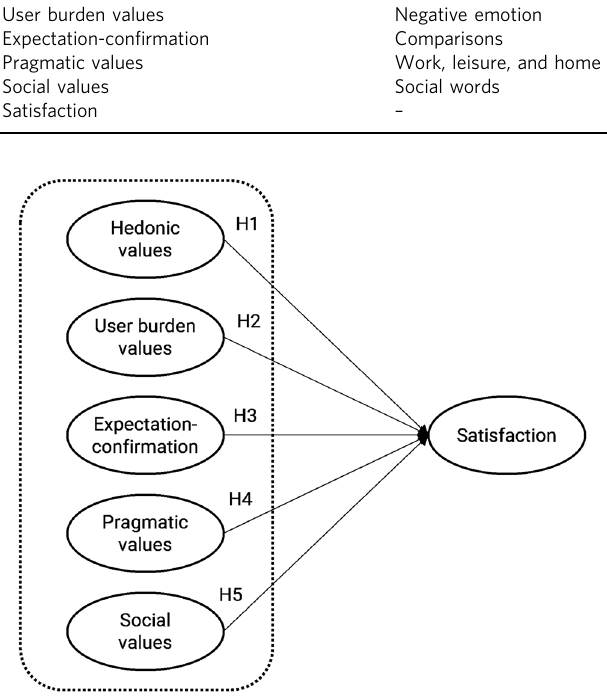
Fig. 3 Research model in Study